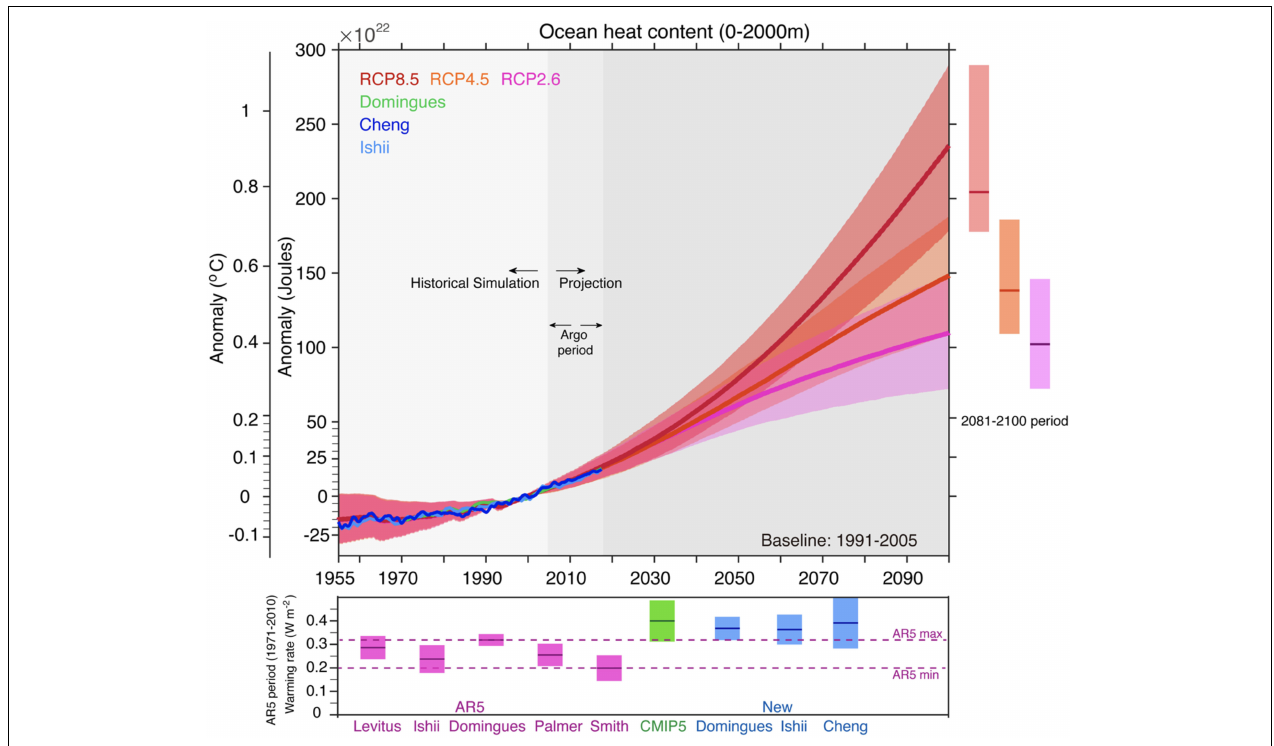
FIGURE 5 | Observational ocean heat content changes for the upper 2000 m from in situ observations in Domingues et al. (2008), Cheng et al. (2017), and Ishii et al. (2017), compared with the ensemble means of the CMIP5 models for historical simulations pre-2005 and projections after 2005. Model calculations performed for emissions projections RCP2.6, RCP4.5 and RCP8.5 (Taylor et al., 2012). All error bars are 90% confidence interval. Credit: Lijing Cheng.